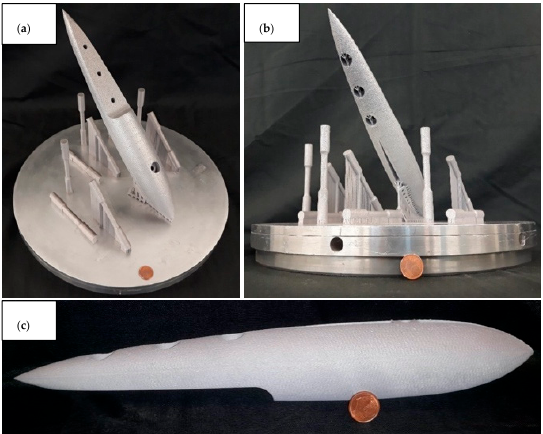
Figure 15. ( a ) Frontal, ( b ) back perspectives on built platform, ( c ) bulb after sandblasting.